Question: Judging by this figure, is the value going up or going down?
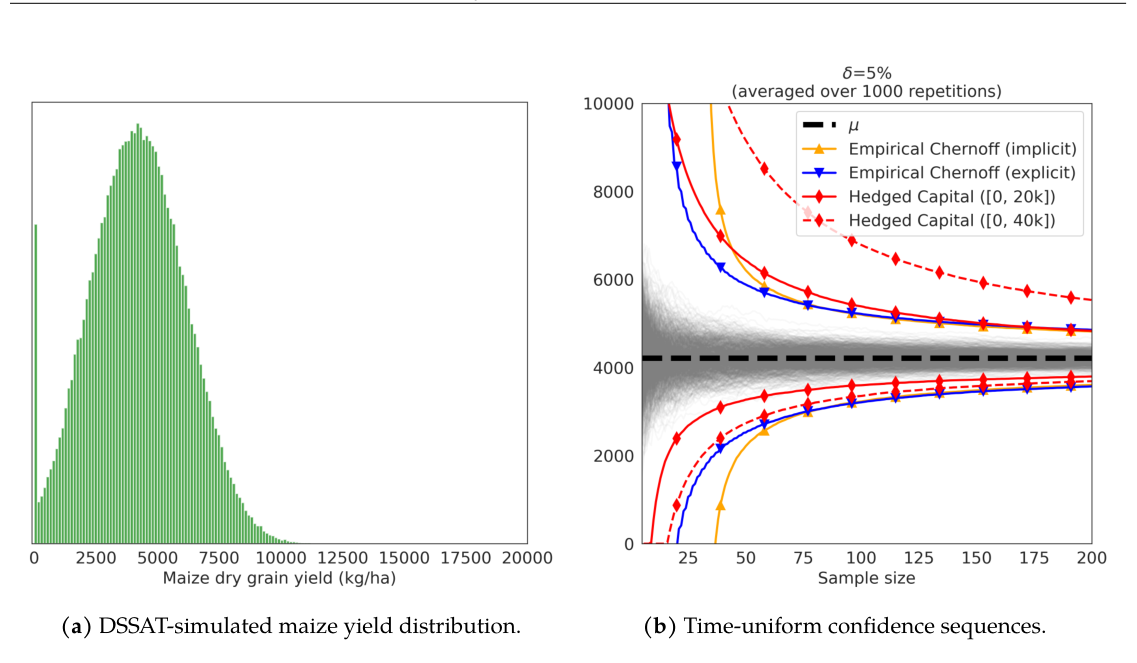
Answer: increasing